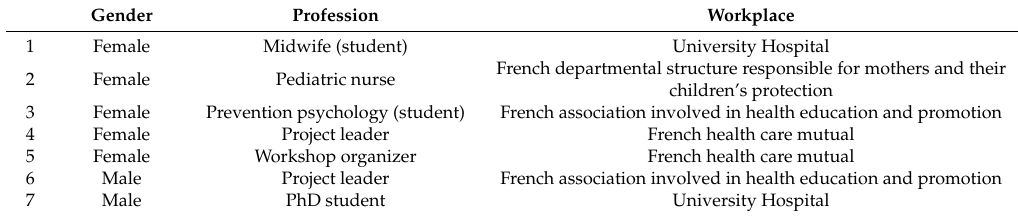
Table A2. Characteristics of the focus group